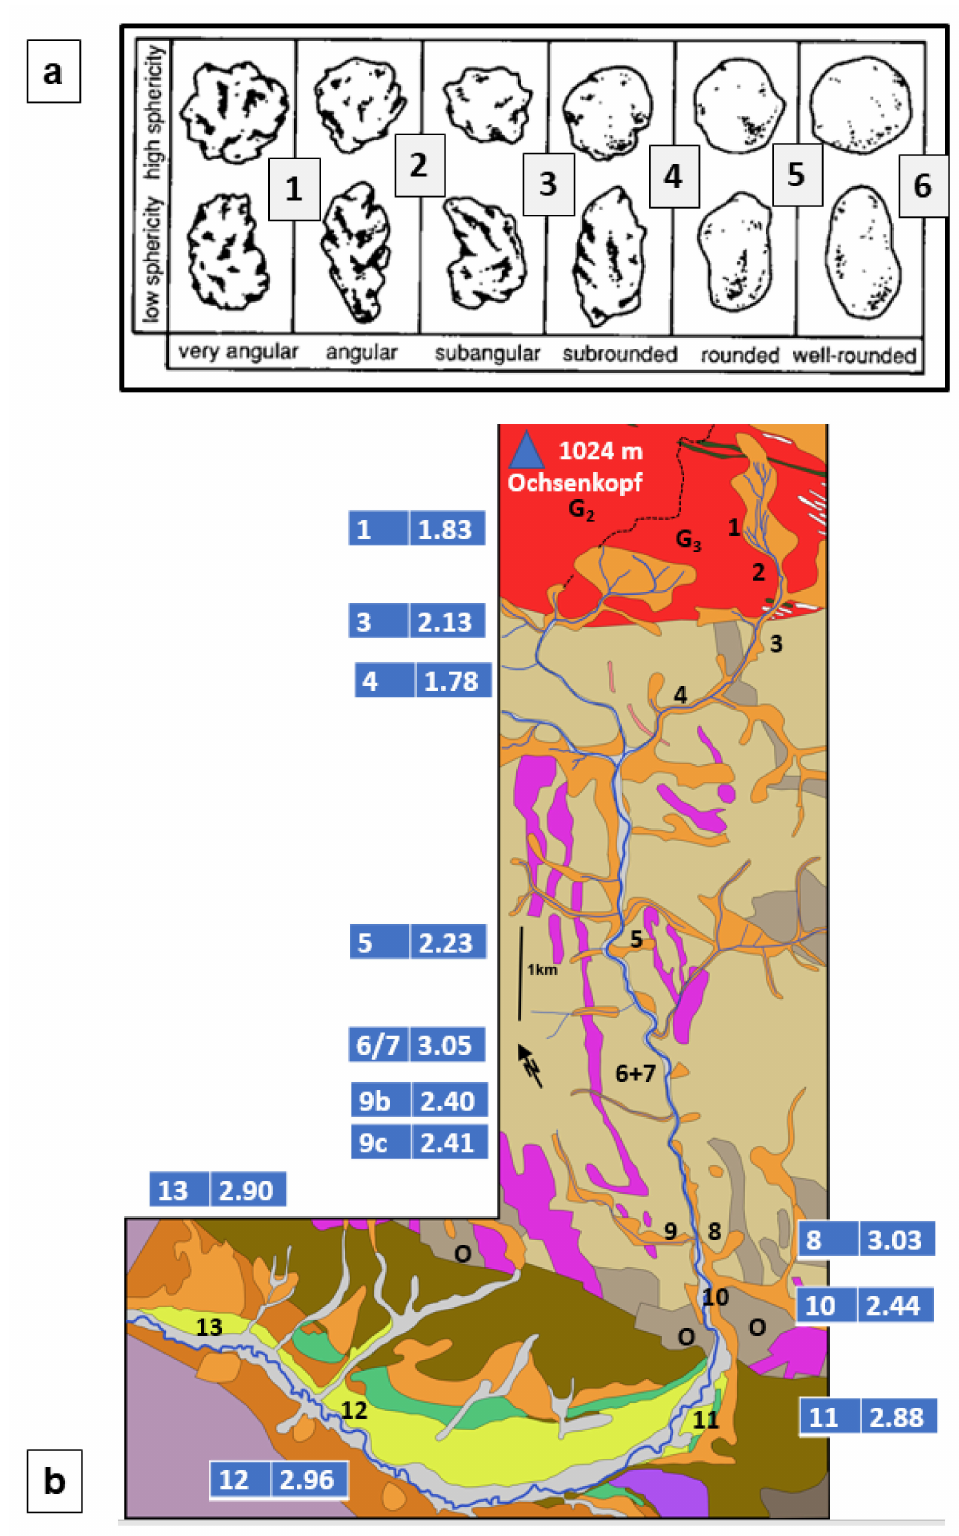
Figure 10. Sphericity and roundness of gravel clasts. ( a ) Six-fold comparison charts of sphericity and roundness according to Powers [23,85]. ( b ) Mean roundness as a function of lithology and distance to source. For geology see Figure